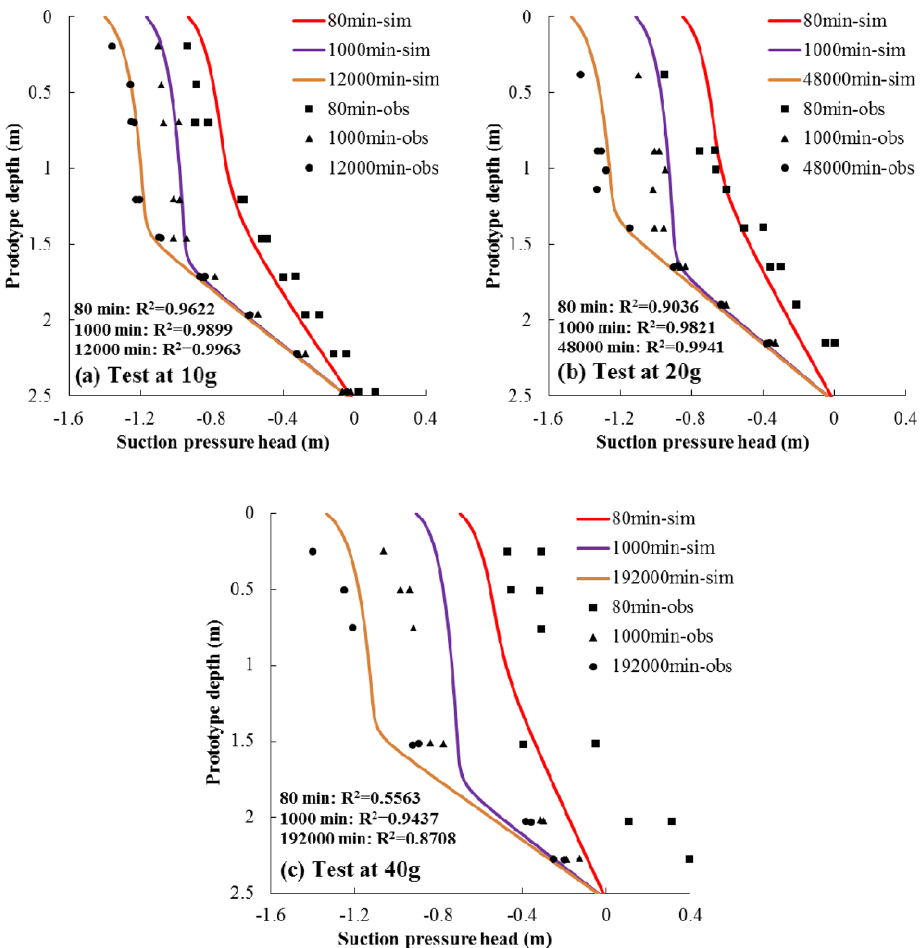
Figure 6. Simulation results (solid lines suffixed with “-sim”) versus transient flow data (points suffixed with “-obs”) collected by Nakajima and Stadler 14 , the prototype time shown in the figures has a relationship with centrifugal modeling time and the mathematical expression is: t p = N 2 t m . The coefficients of determination (R 2 ) for all the comparisons are also listed in the